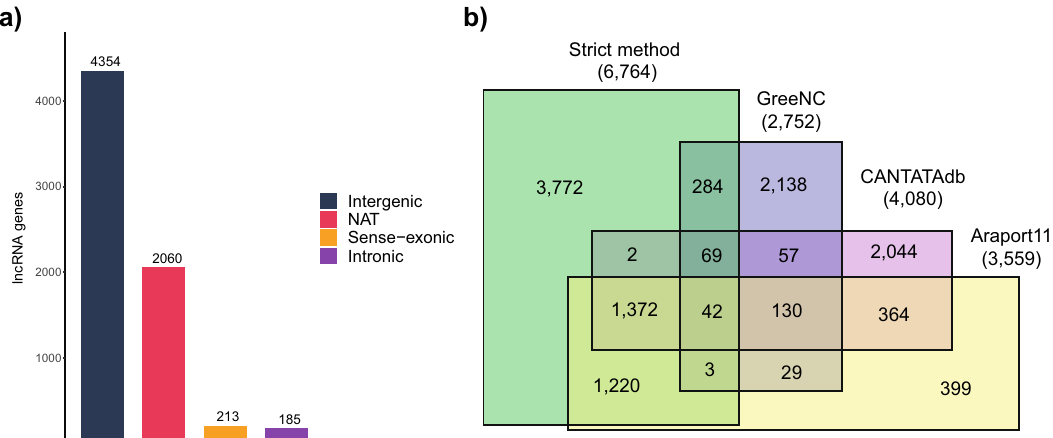
Figure 1. Annotation of lncRNA genes and comparisons with other plant lncRNA databases. ( a ) Distribution of the 6764 lncRNA genes predicted by the SM. ( b ) Venn diagram comparing the SM (green) with the databases GreeNC (purple), CANTATAdb (pink) and Araport11(yellow) where the lncRNAs have been annotated from A. thaliana . SM = Strict